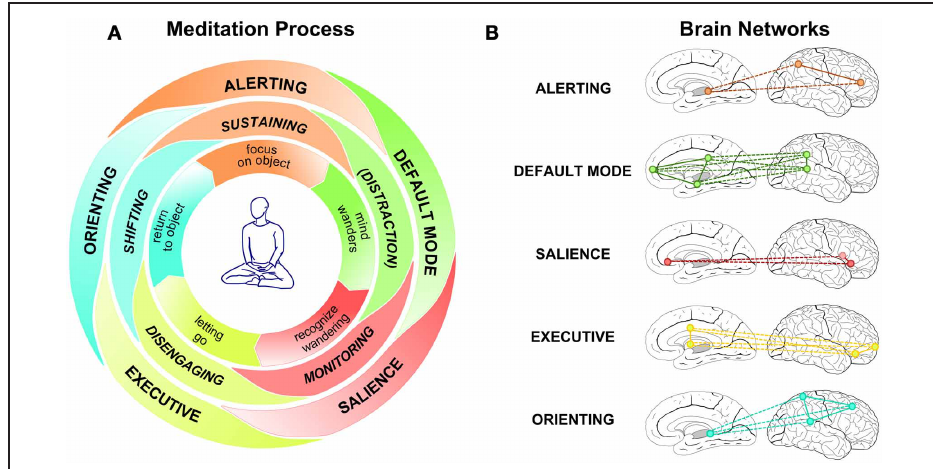
FIGURE 2 | Effortful attention regulation during meditation. Panel (A) provides a schematic representation of the meditation process. The inner circle outlines the phenomenological layer, presenting the typical sequence (clockwise) a meditator will go through. The middle circle relates the attentional processes that lie underneath, while the outer circle represents the different brain networks that are involved in carrying out these functions. The different attentional processes and the brain networks are represented as partially overlapping to indicate that in many instances more than one process/network is involved. Panel (B) outlines the main brain areas involved in each of the five networks. Anatomical details are discussed in the main